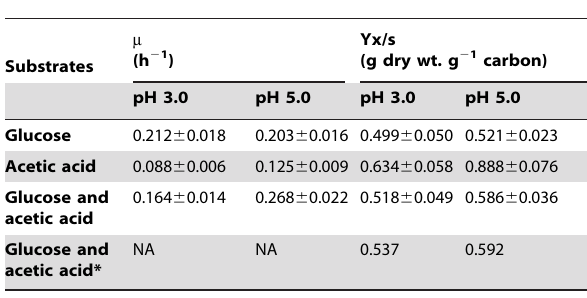
Table 1. Specific growth rates (h 2 1 ) and biomass yields of